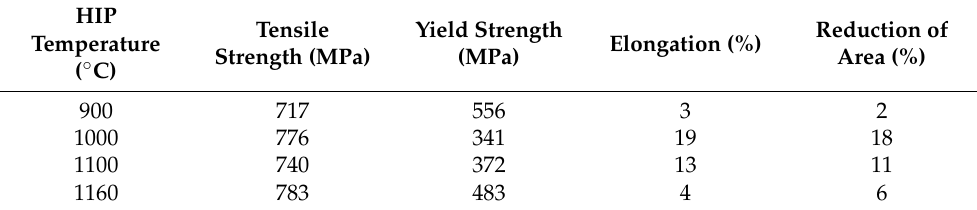
Table 3. Mechanical properties of BSS at different HIP sintering